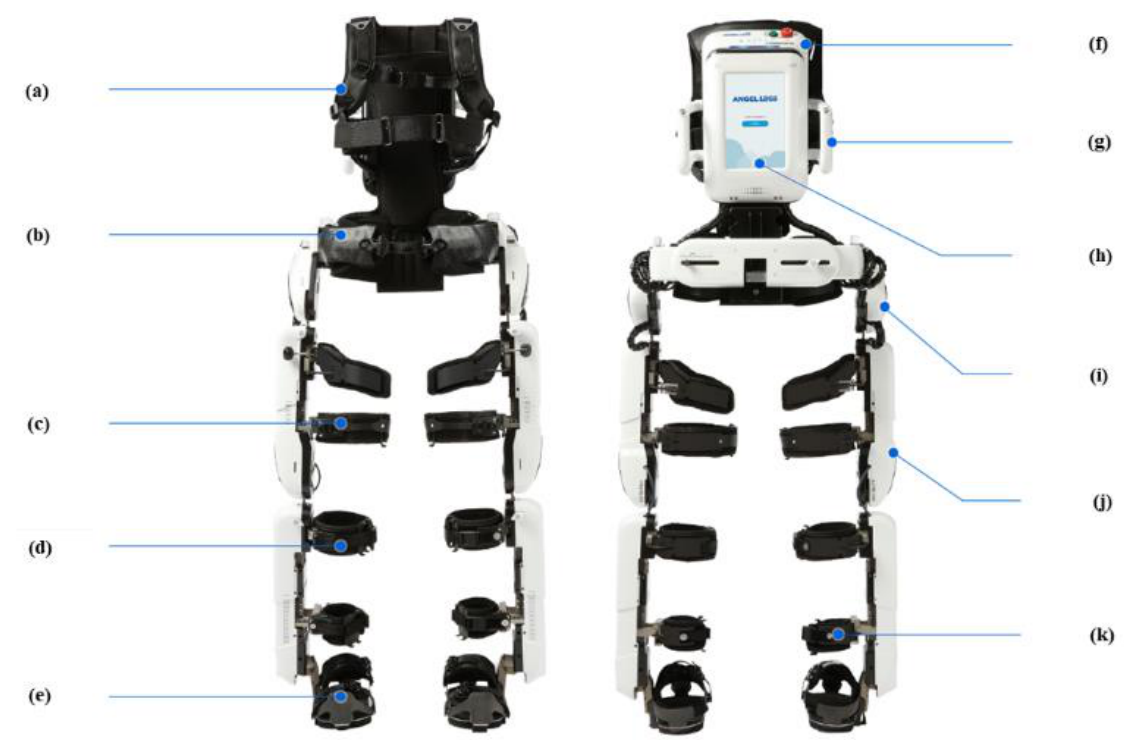
Figure 1. Untethered exoskeleton used in this study. ( a ) shoulder strap, ( b ) back strap, ( c ) thigh band, ( d ) calf band, ( e ) outsole, ( f ) battery cover, ( g ) handles held by an assistant to prevent side-to-side sway and assist weight-shift during training, ( h ) tablet used to control the starting or stopping of the robot, ( i ) actuator for the hip joint, ( j ) actuator for the knee joint, ( k ) ankle band.